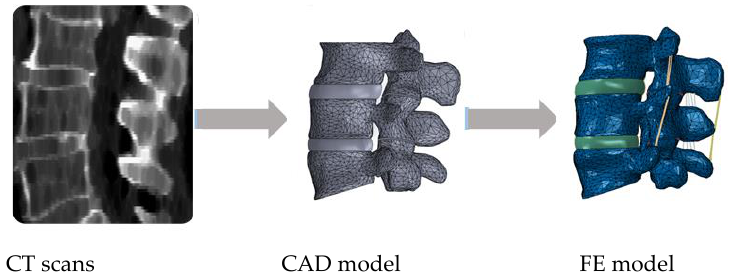
Figure 1. Example of a common pathway for patient-specific finite element (FE) modelling of the spine, going from medical imaging to the final FE model.